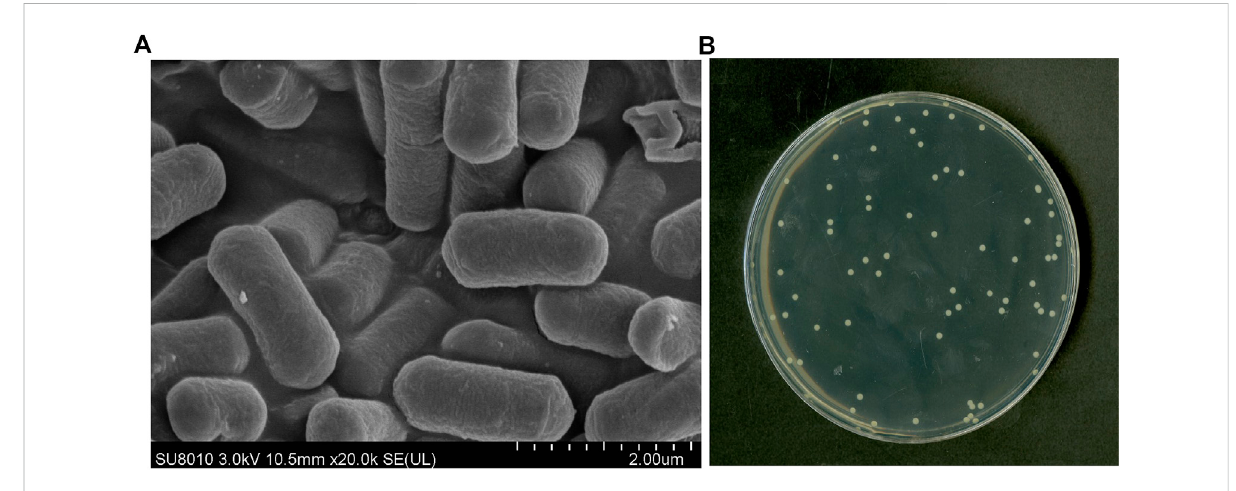
FIGURE 1 Transmission electron micrograph of strain KJ-1 (A) and physiological and biochemical morphology of strain KJ-1 on MSM agar medium